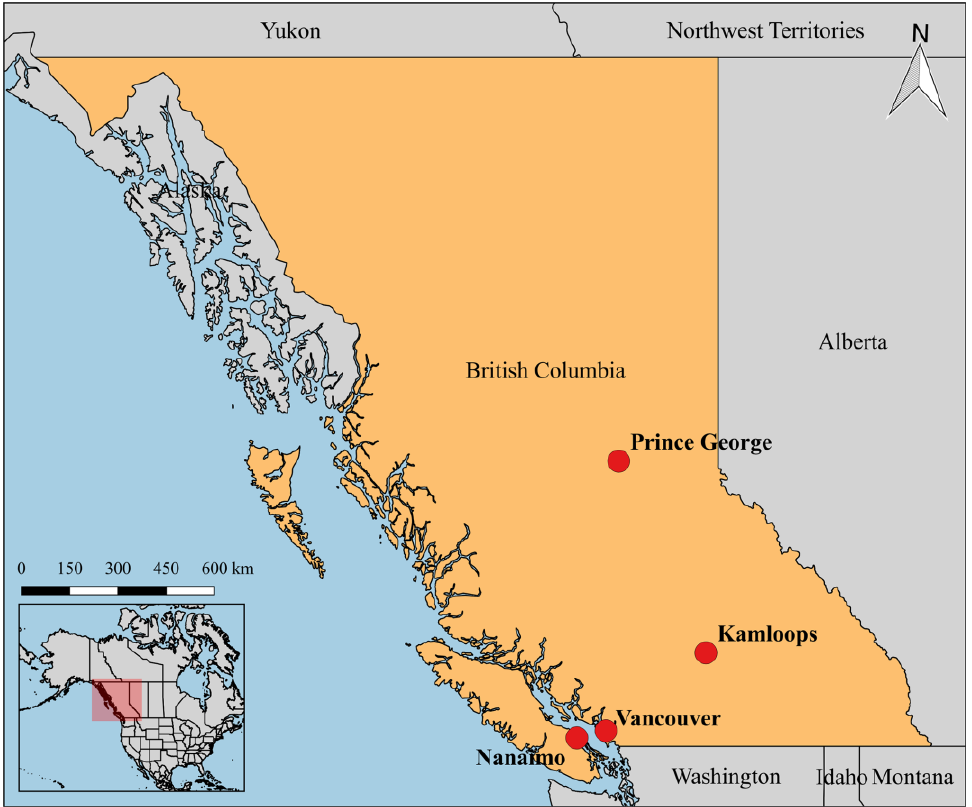
Figure 2. Map showing the locations where the engagement process was carried out.